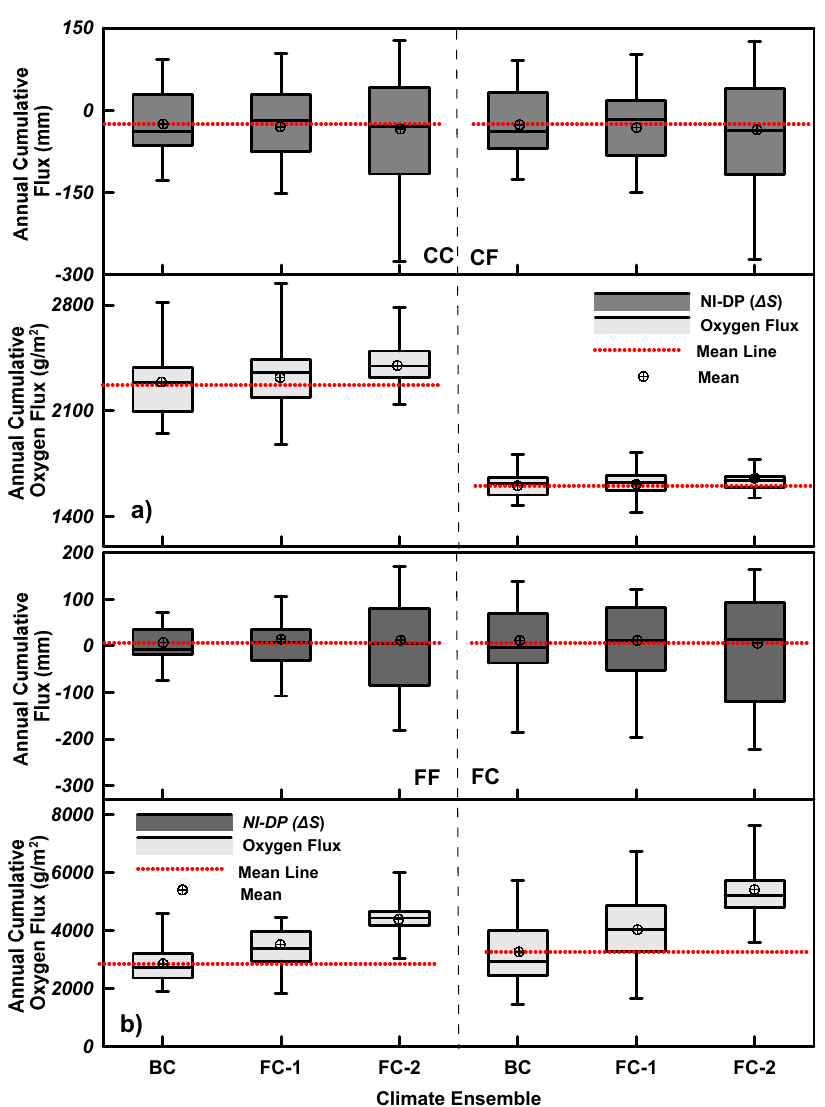
Figure 9. Box and whisker plots for the annual change in storage and surface oxygen flux for ( a ) the CC and CF profiles and ( b ) the FF and FC profiles.